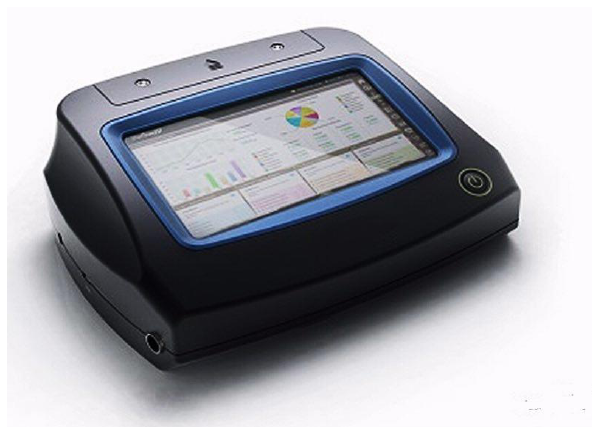
Figure 3. Photo of the QCM-based e-nose.